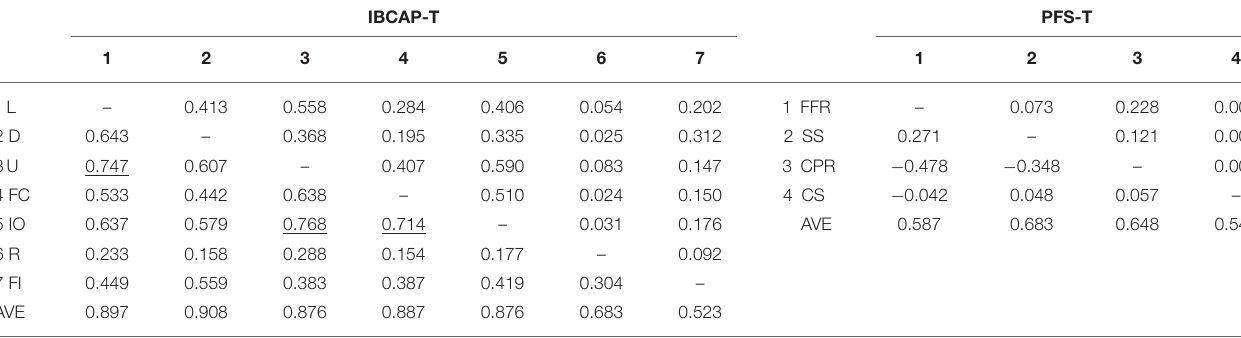
TABLE 5 | Evidence of convergent and discriminant validity of the IBCAP-T and PFS-T ( N